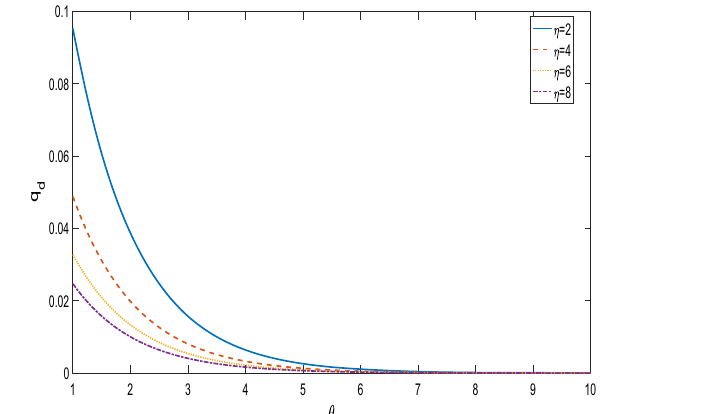
Fig. 7 Dimensionless discharge w.r.t. dimensionless time for ζ = 10 , η = 2 , 4 , 6 , 8 and fractional order α = 0 . 90 , β = 0 . 90